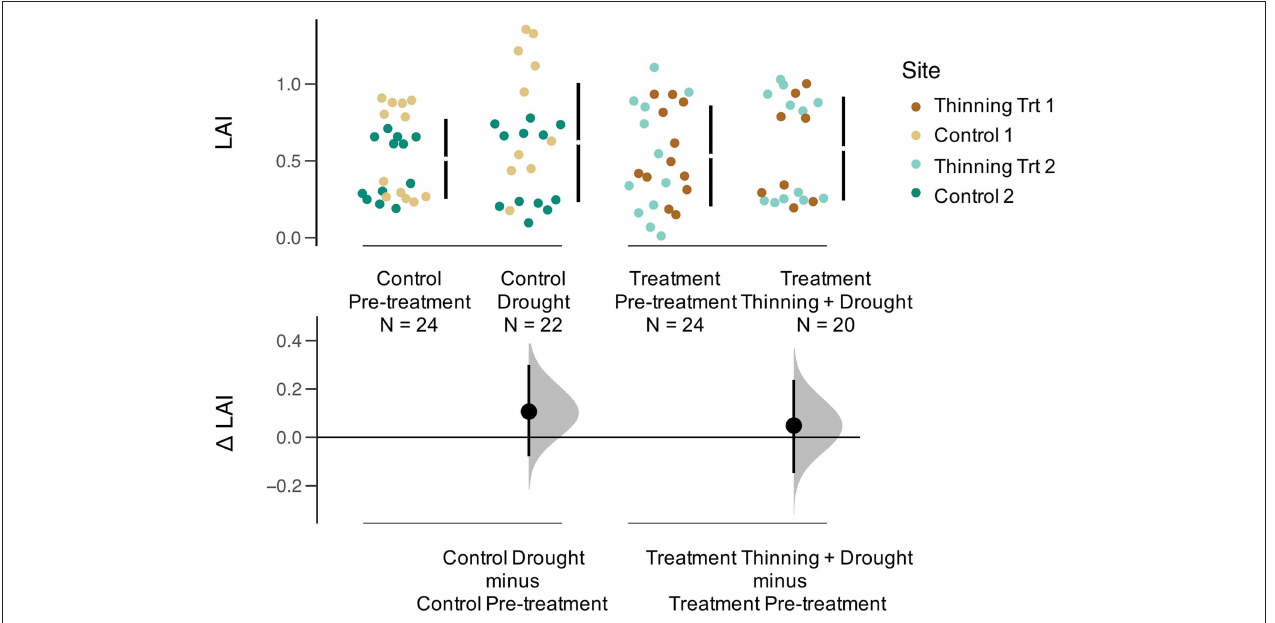
FIGURE 5 | Gardner-Altman plot of leaf area index (LAI) for Pre-treatment Control, Drought Control, Pre-treatment, and Thinning + Drought Treatment. Colors represent the four sites. The change in LAI ( 1 LAI, or effect size) is compared between the control and treatment, as well as pre-treatment and drought/thinning + drought